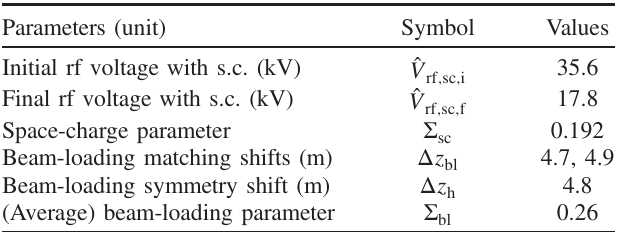
TABLE III. Main initial parameters of bunch merging with space charge and beam loading in CSNS-II/RCS.